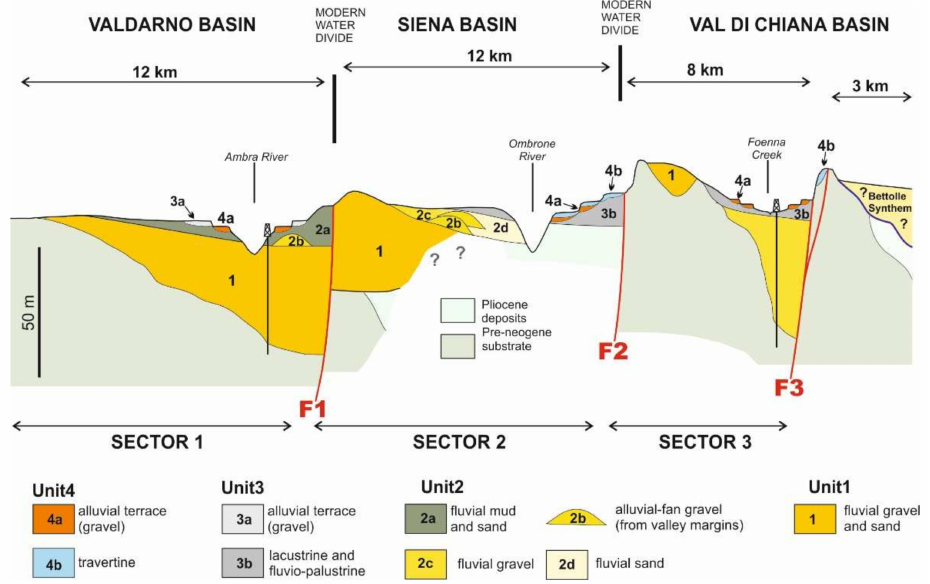
Figure 9. Schematic cross section along the axis of the study sedimentary